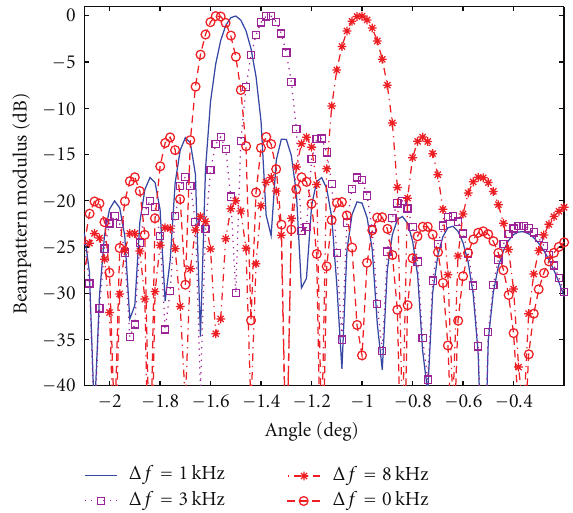
Figure 3: The frequency increment-dependent beam steering angle.